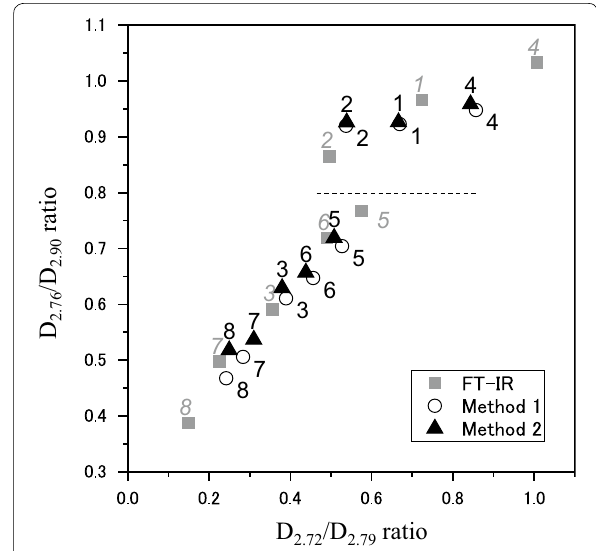
Fig. 9 Relationship between the D 2.72 / D 2.79 ratio and the D 2.76 / D 2.90 ratio. A broken line shows a gap at an arbitrarily D 2.76 / D 2.90 value of 0.8. The most hydrous chondrites ( 1 , 2 ) and Winselwan ( 4 ), which has a characteristic narrow peak at 2.72 μm, plot above the line . On the other hand, the other chondrites are clustered below the line . Labels: 1 Murchison, 2 Murray, 3 Y-793321, 4 Jbilet Winselwan, 5 Y = = = = = 982086, 6 Y 980115, 7 Y-86720, and 8 = = =